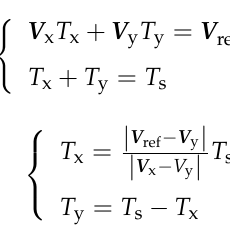
Table 3. System parameters.